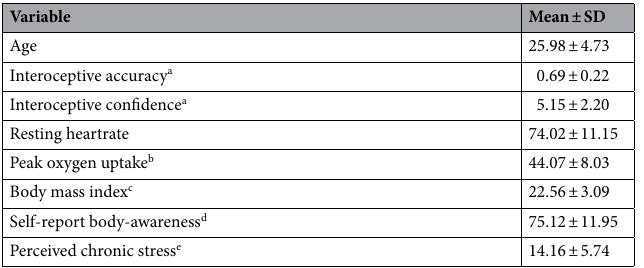
Table 1. Background characteristics of all participants presented as means ± standard deviation. Interoceptive accuracy a (IAcc) as measured by Heartbeat Counting Task (HCT—accuracy range: 0–1, and confidence range: ˙ V 0–10), Peak oxygen uptake b ( O 2peak ), Body mass index c (BMI), Self-report body-awareness d —Measured